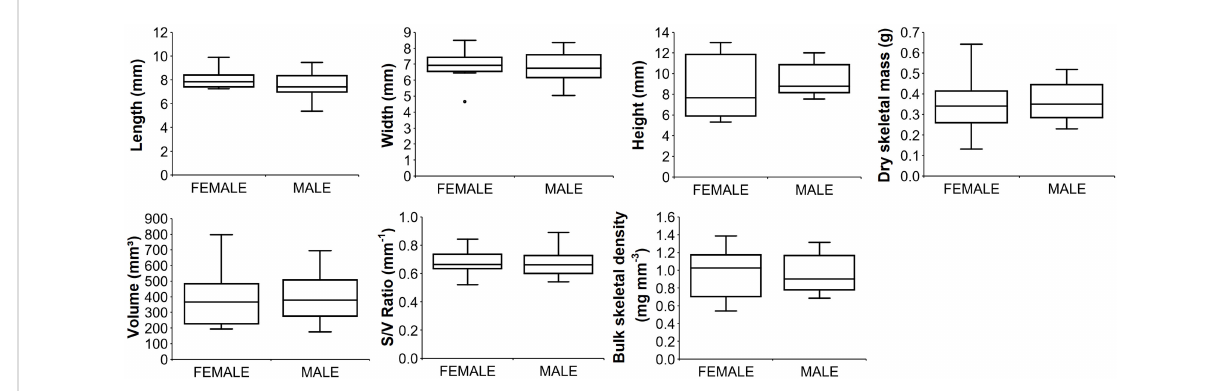
FIGURE 3 Boxplots of biometric parameters for male and female polyps. Median (solid horizontal line), fi rst and third quartiles (box outline), and outliers (circles). Number of polyps analyzed: 12 for females; 13 for